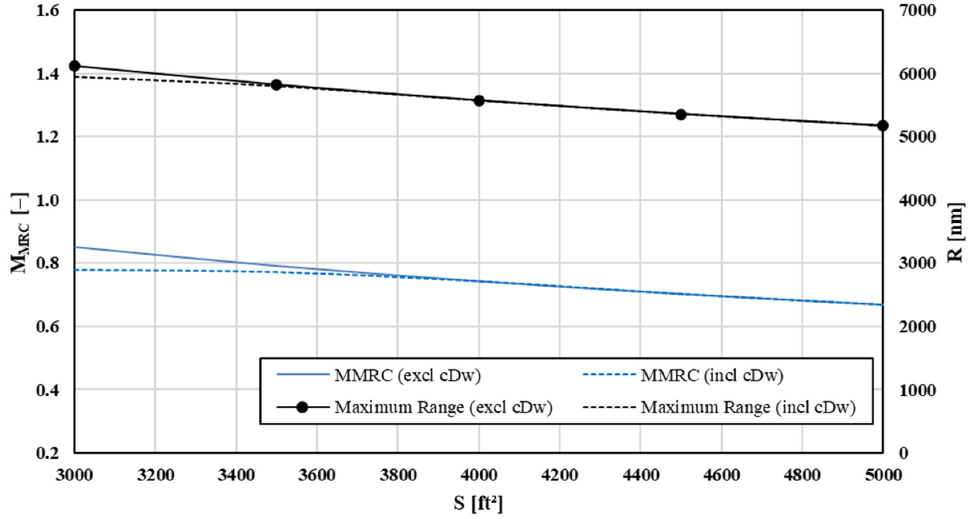
Figure 10. M MRC and range over wing surface area for both models, including and excluding C Dw . If transonic-flow normal shocks are ignored, the sweep-angle Λ parameter does not change the total drag significantly. Range and maximum cruise range airspeed remain constant in that case, as shown in Figure 11. With wave drag included, increasing leading- edge sweep delays critical flow conditions on the wing’s upper surface to higher Mach numbers as the LE perpendicular velocity component diminishes. A good example is Con- corde, which, although flying supersonically, had subsonic double-ogee wing planform. Thereby, C Dw decreases and efficient flight at higher forward speeds is enabled. Accord- ingly, both V MRC and range also increase steadily with Λ ( M DD increases with increasing sweep angle according to modified Korn equation). Wave drag decreases with increased sweep, a relation that is noticeable also with the drag proportions in Figure 12 and range and M MRC data presented in Table 6.